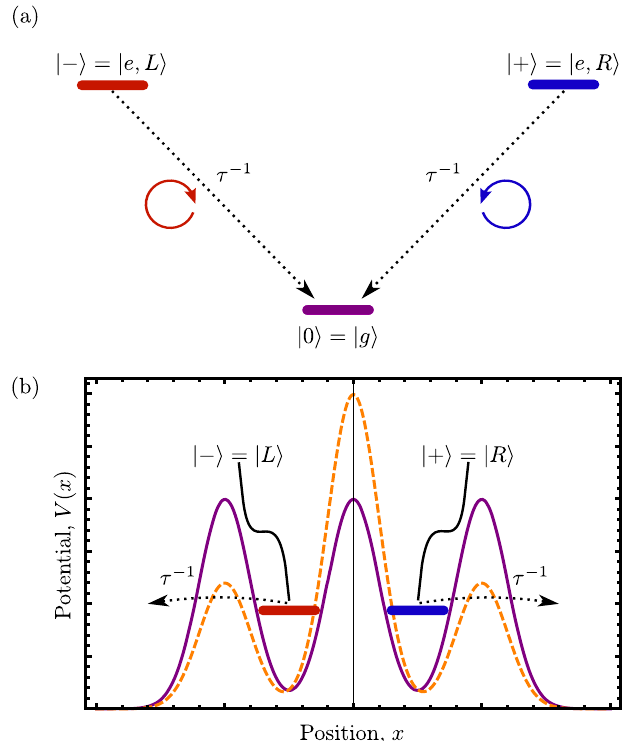
FIG. 7. (a) Readout scheme based on state-dependent polari- zation of an emitted photon. When the state is jþi ¼ j e; R i ( j − i ¼ j e; L i ) in the excited subspace, a right (left) circularly polarized photon is emitted. Both states decay to the ground state j 0 i ¼ j g i on a time scale τ . (b) Similar scheme for readout of the charge state of a double quantum dot. When the electron is in the right (left) island j R i ( j L i ), it is detected after tunneling into the right (left) lead. Both states tunnel into the leads on a time scale τ , leaving the double quantum dot in the empty state j 0 i